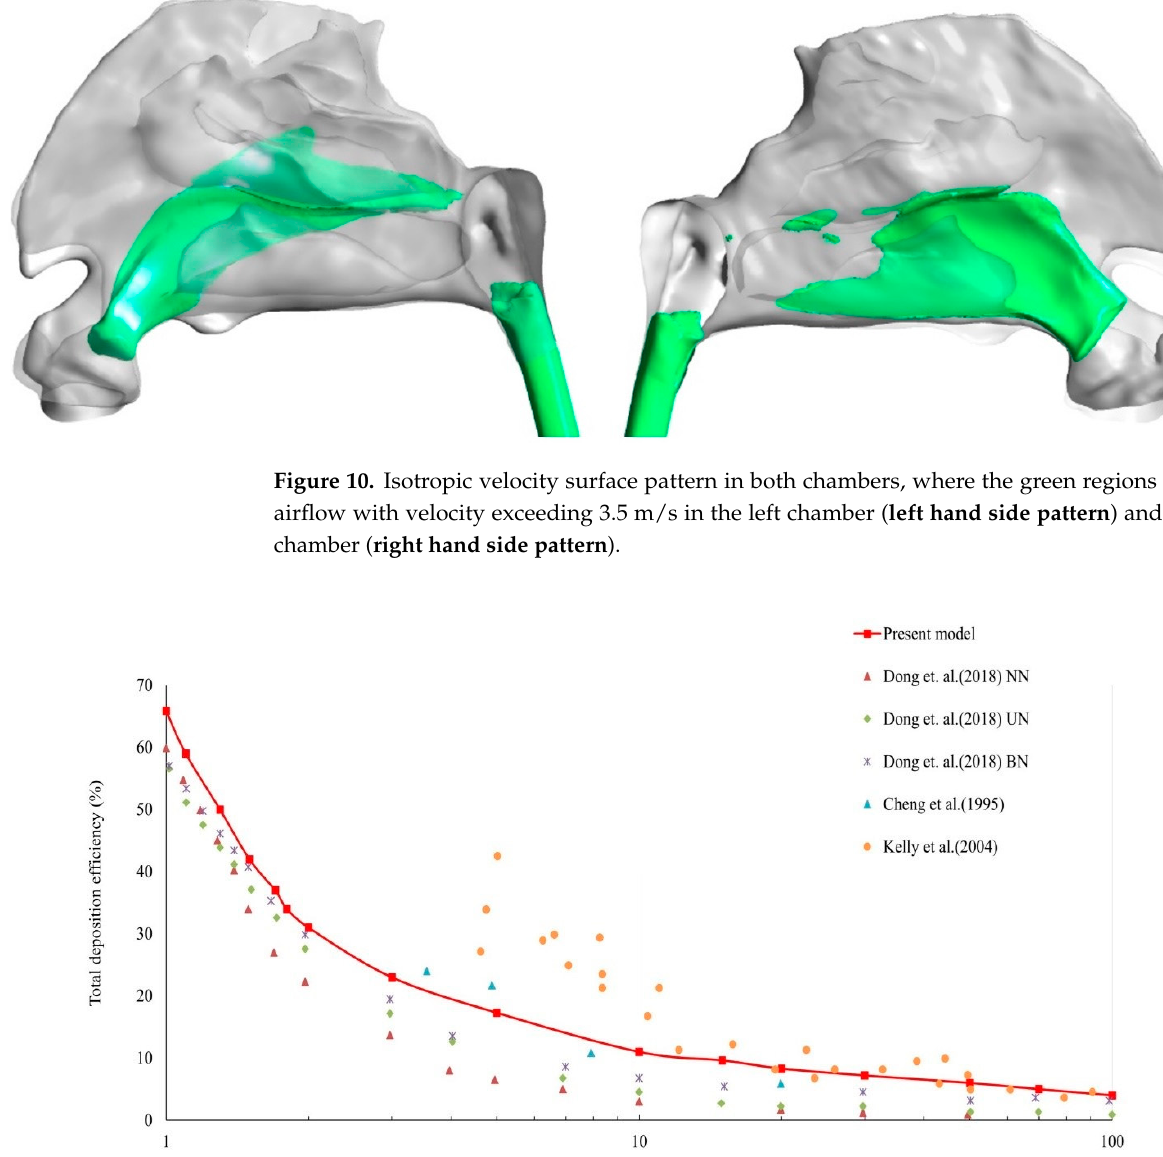
Figure 10. Isotropic velocity surface pattern in both chambers, where the green regions show the airflow with velocity exceeding 3.5 m/s in the left chamber ( left hand side pattern ) and the right chamber ( right hand side pattern ).